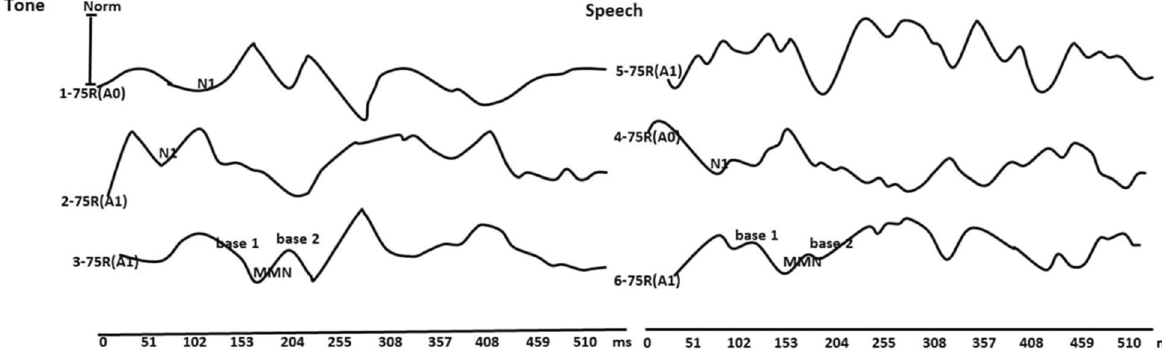
Fig. 2 Abscece of N1 in one case of early schizophrenic